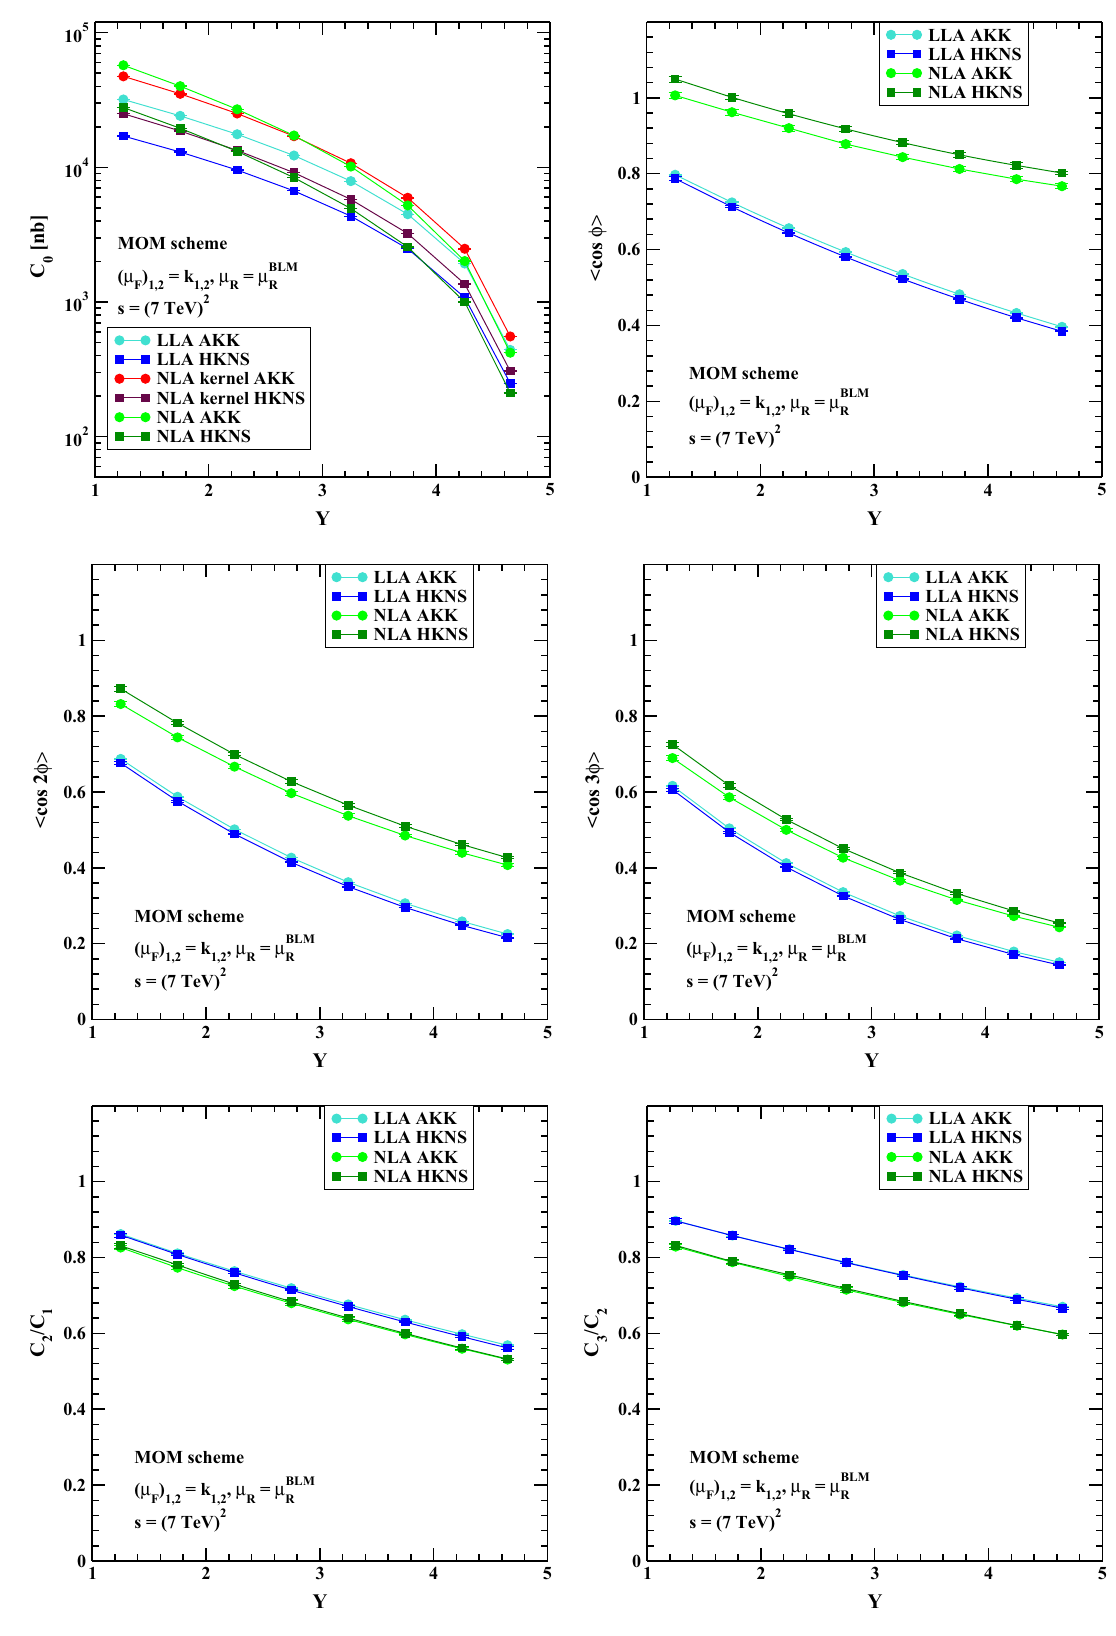
Fig. 7 Y -dependence of C 0 and of several ratios C m / C n for (μ F ) 1 , 2 = |(cid:6) k 1 , 2 | ,